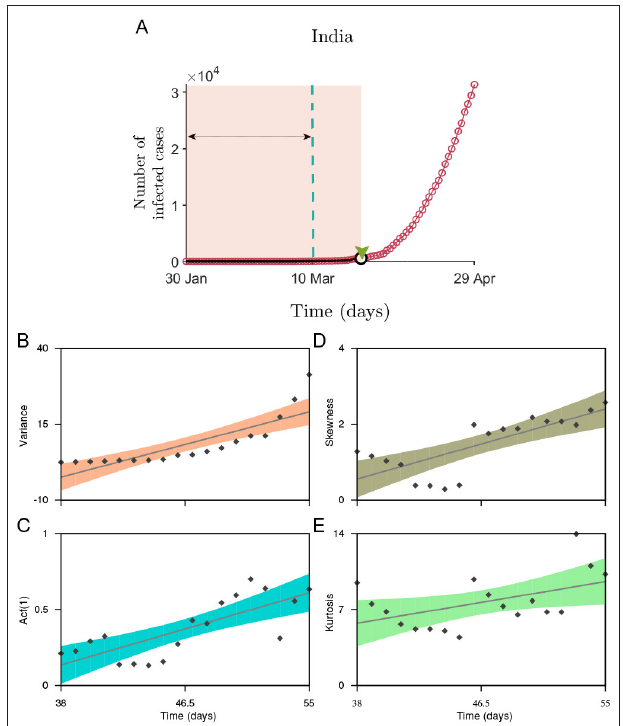
FIGURE 3 | Statistical analysis to measure the indicators of CSD for the dataset of India up to the date of the nationwide lockdown. (A) The incidence curve depicting the fraction of people infected from January 30 up to April 29. The shaded region is the data used to calculate the changes in the generic indicators. The arrow marks the size of the rolling window used to calculate the statistical signals. The estimated values of the slowing down indicators (B) variance, (C) autocorrelation function at lag-1, (D) skewness, and (E) kurtosis. Solid lines are the fitted linear regression models to analyze the trend in the indicators along with the confidence bounds (shaded